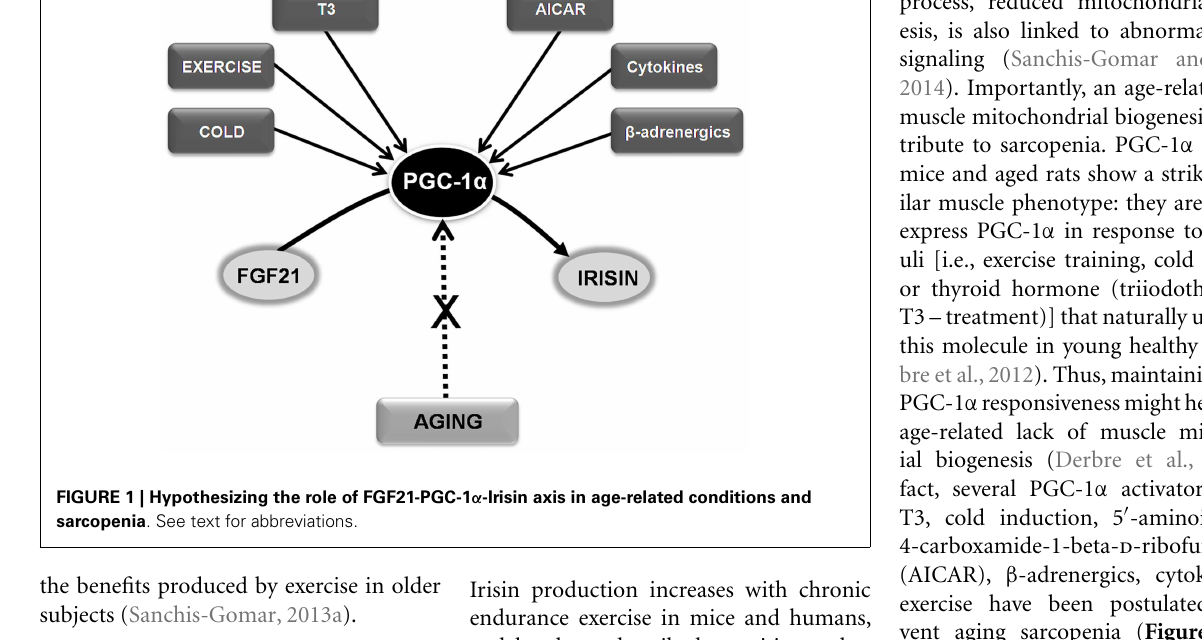
the benefits produced by exercise in older subjects (Sanchis-Gomar,